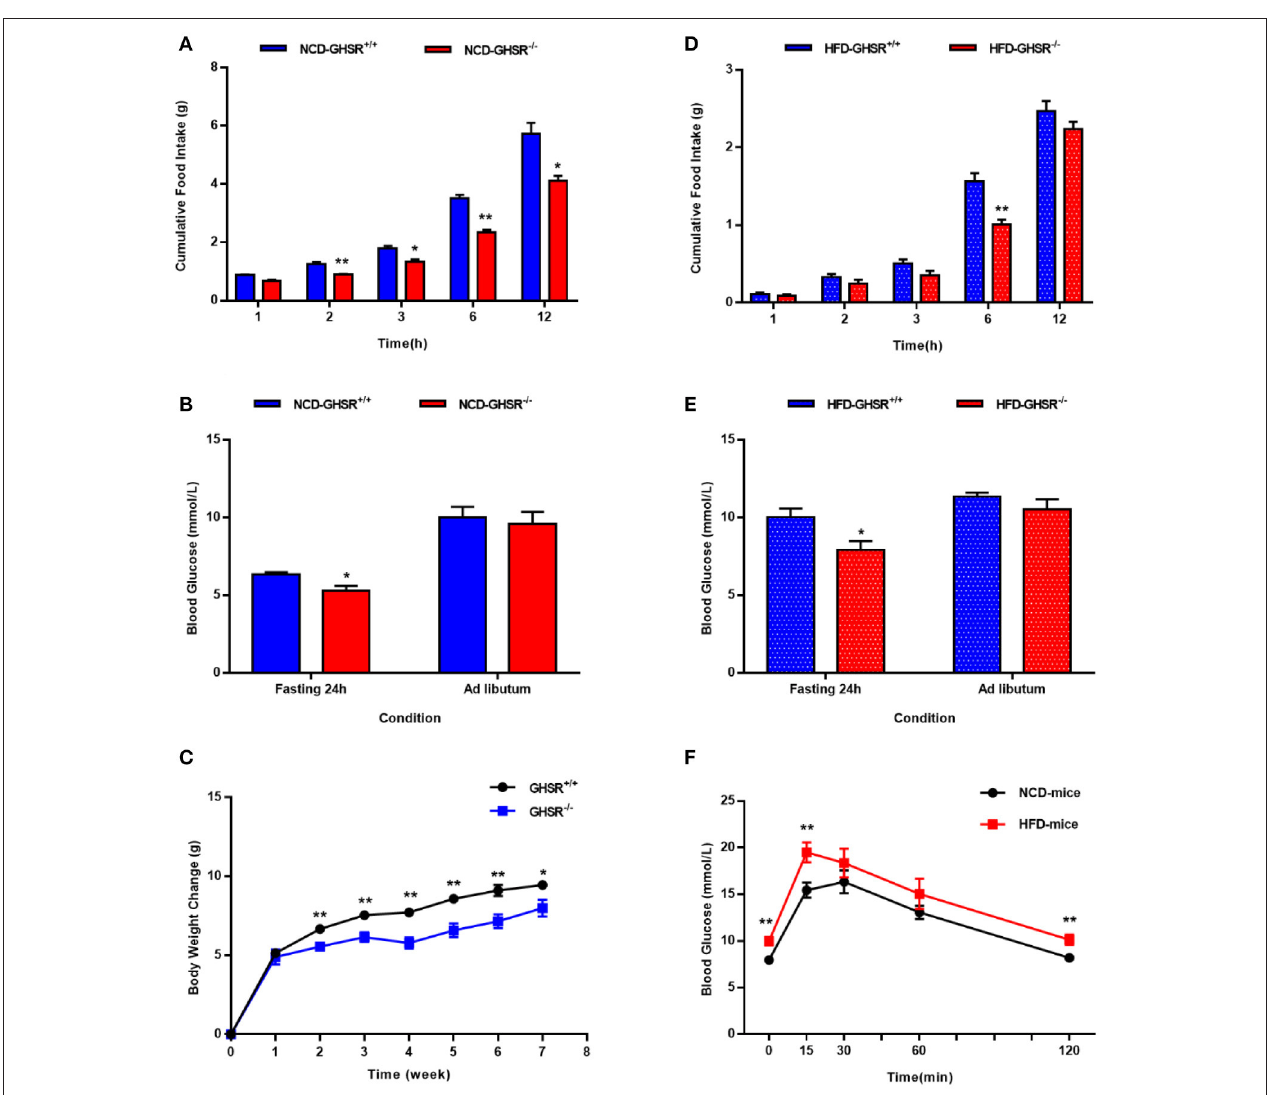
FIGURE 1 | The differences between GHSR + / + and GHSR − / − mice in food intake and blood glucose. Eight-week-old GHSR + / + and GHSR − / − mice were fed with NCD or HFD for 8 weeks: then mice were inspected respectively. (A,D) Cumulative food intake in GHSR + / + and GHSR − / − mice fed with (A) NCD or HFD tested after mice fasting for 6h. (B,E) Blood glucose in GHSR + / + and GHSR − / − mice fed with (B) NCD or (E) HFD under ad libitum or 24h fasting conditions. (C) Changes in body weight during 8 weeks of HFD. (F) Oral glucose tolerance tests (OGTT) in mice fed with NCD and HFD. (A,B,D,E) NCD-GHSR + / + : n = 4; NCD-GHSR − / − : n = 3; HFD-GHSR + / + : n = 6; HFD-GHSR − / − : n = 6. (C) n = 10/group. (F) n = 12/group. Data are expressed as mean ± SEM. (A–E) * P < 0.05, ** P < 0.01 for the effect of GHSR − / − mice vs. GHSR + / + mice; (F) ** P < 0.01 for the effect of HFD-mice vs. NCD-mice. Student’s t -test was applied to analyze the statistical